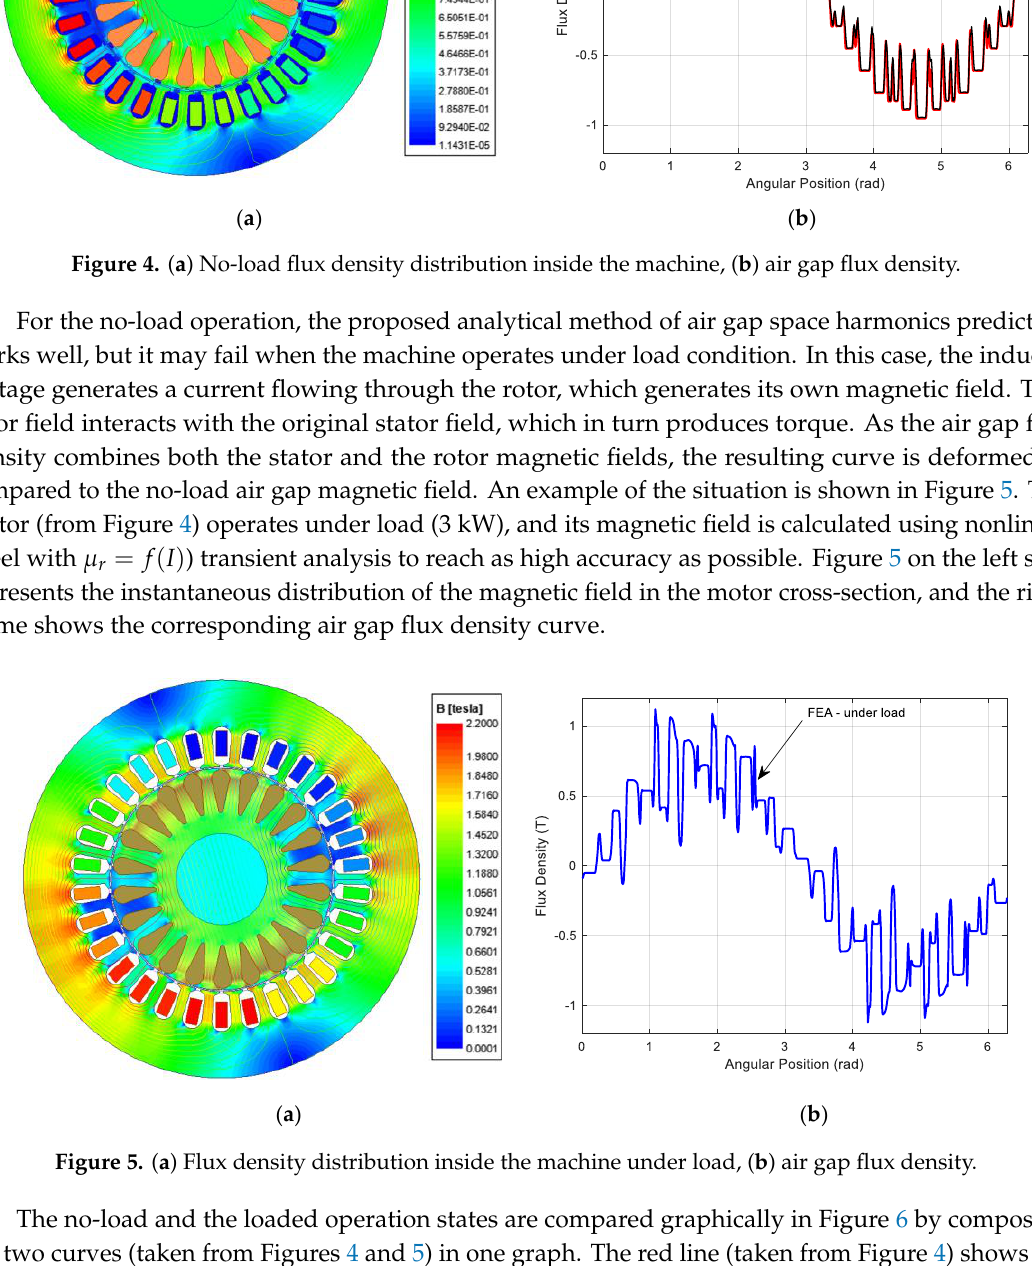
Figure 5. ( a ) Flux density distribution inside the machine under load, ( b ) air gap flux density.